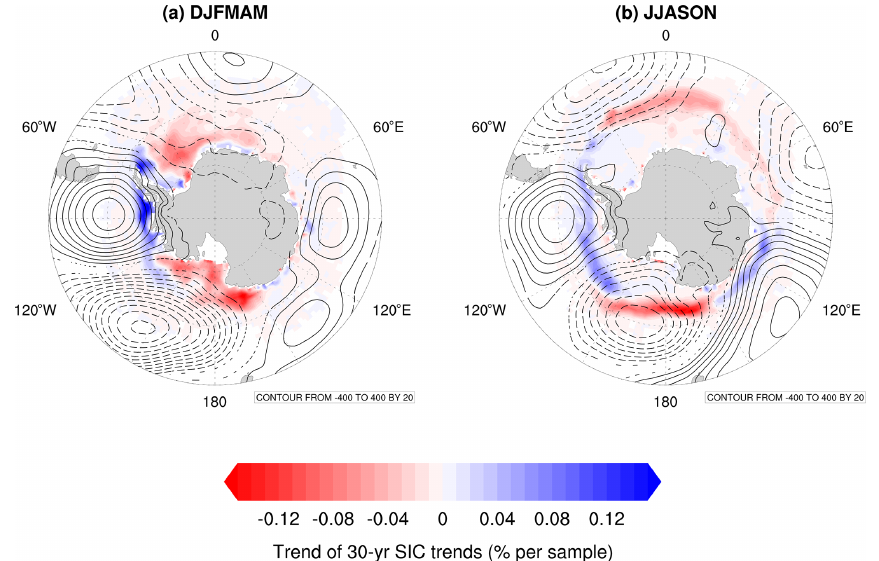
Figure 7. Shading shows the slope of running 30-year seasonal trends of sea ice concentration (SIC) during (a) December–May and (b) June– November, overlaid by contour lines depicting the difference in the asymmetric component of SAM between the earliest 15-year sample (1979–1993) and the most recent (2007–2021). Negative contours (enhanced anticyclonic flow) are shown by dashed lines; positive contours (enhanced cyclonic flow) are shown by solid